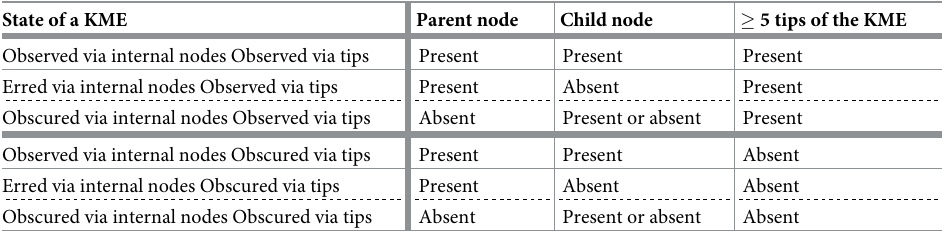
Table 1. Definitions of key migration event (KME) states in a downsampled